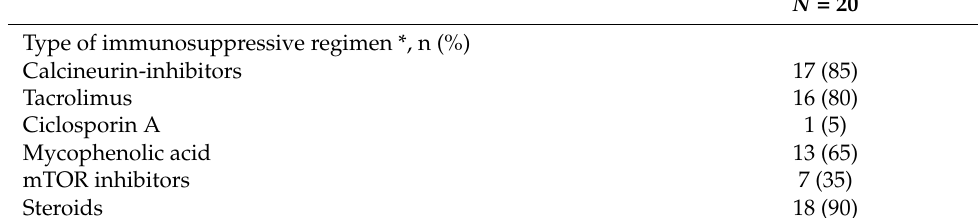
Table 1. Cont. Type of immunosuppressive regimen *, n (%) Calcineurin-inhibitors 17 (85) Tacrolimus 16 (80) Ciclosporin A 1 (5) Mycophenolic acid 13 (65) mTOR inhibitors 7 (35) Steroids 18 (90) Belatacept 3 (15) Neutrophil count before vaccination (/mm 3 , mean ± SD) 5622 ± 2842 Lymphocyte count before vaccination (/mm 3 , mean ± SD) 1571 ± 764 CD4+ T-cell count before vaccination (/mm 3 , mean ± SD) 546 ± 311 CD8+ T-cell count before vaccination (/mm 3 , mean ± SD) 451 ± 308 CD19+ T-cell count before vaccination (/mm 3 , mean ± SD) 91 ± 85 NK cell count before vaccination (/mm 3 , mean ± SD) 253 ± 232 eGFR before vaccination (mL/min/1.73 m 2 ) 51 ± 19 Neutrophil count before 4th dose (/mm 3 , mean ± SD) 6125 ± 2978 Lymphocyte count before 4th dose (/mm 3 , mean ± SD) 1061 ± 805 eGFR before 4th dose (mL/min/1.73 m 2 ) 46 ±